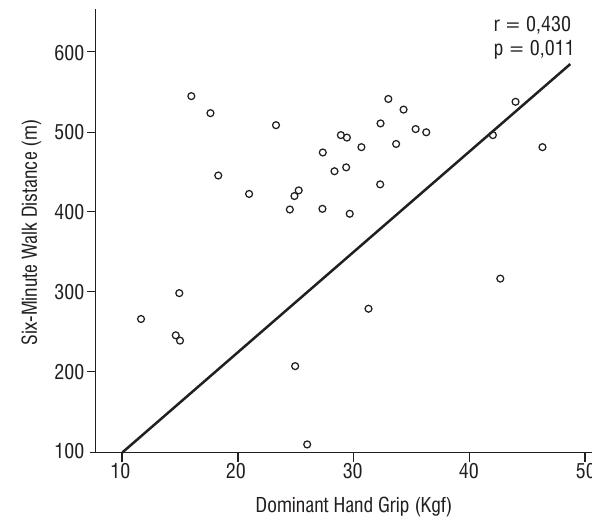
Figure 1 - Correlation between 6MWT (m) and dominant Hand Grip.